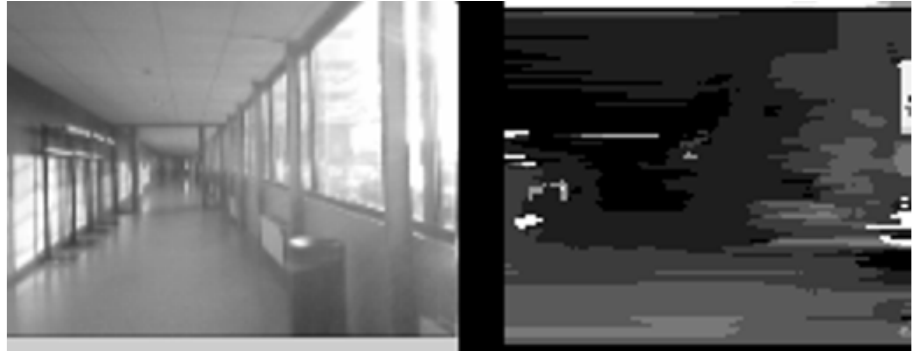
Figure 3. Result of the implemented stereo vision method (based on [29]) on images of a corridor, taken by the DelFly Explorer stereo vision